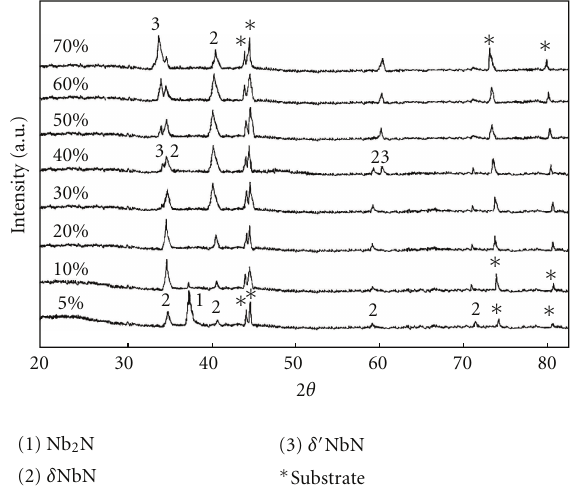
Figure 4: X-ray di ff raction patterns of Nb-N Coatings on SS deposited at 5%–70% of F N